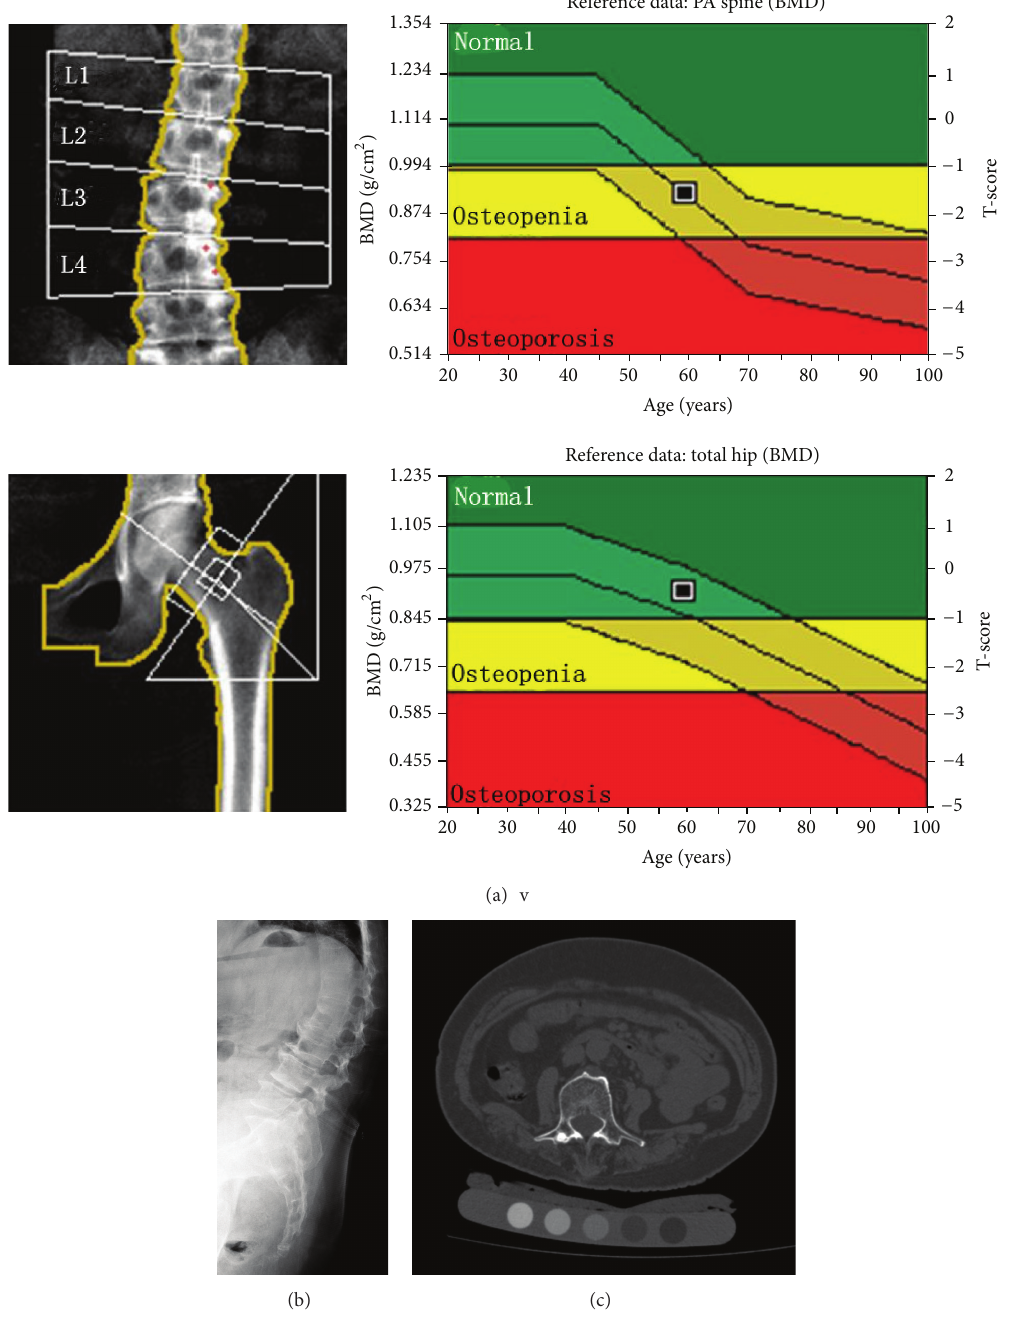
Figure 2: Images obtained from a 59.5-year-old woman who was found by dual X-ray absorptiometry to have osteopenia. (a) The T-scores for lumbar posteroanterior dual X-ray absorptiometry, the femoral neck, and total hip were − 1.6, − 0.5, and − 0.4, respectively. The trabecular bone mineral density of L2–L4 was 71.4mg/cm 3 , indicating a potential diagnosis of osteoporosis according to the American College of Radiology guidelines. A lateral lumbar radiograph (b) and an axial computed tomography image (c) showed severe osteophytes and end plate sclerosis of the lumbar vertebrae. Focal sclerosis is apparent on the right accessory of